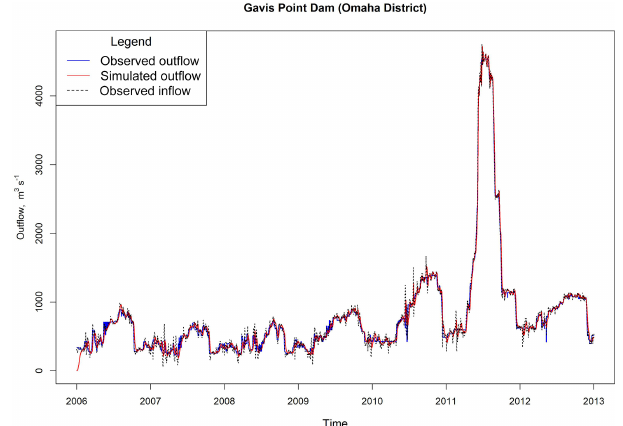
Figure 8. Hydrographs of observed inflow and outflow versus simulated outflow with the highest KGE value at Gavins Point Dam (Döll method k rd = 0 . 04). KGE comparing observed inflow and outflow = 0.99; KGE comparing simulated and observed out- flows =